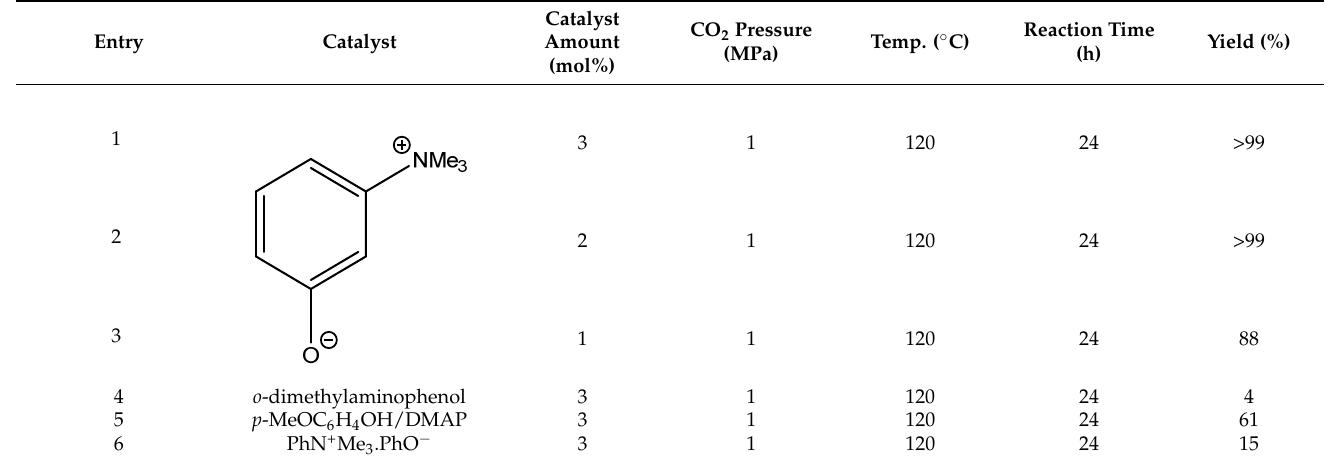
Table 23. Comparison of catalytic action of different substituted phenols on carbonation of hexylene oxide [94].